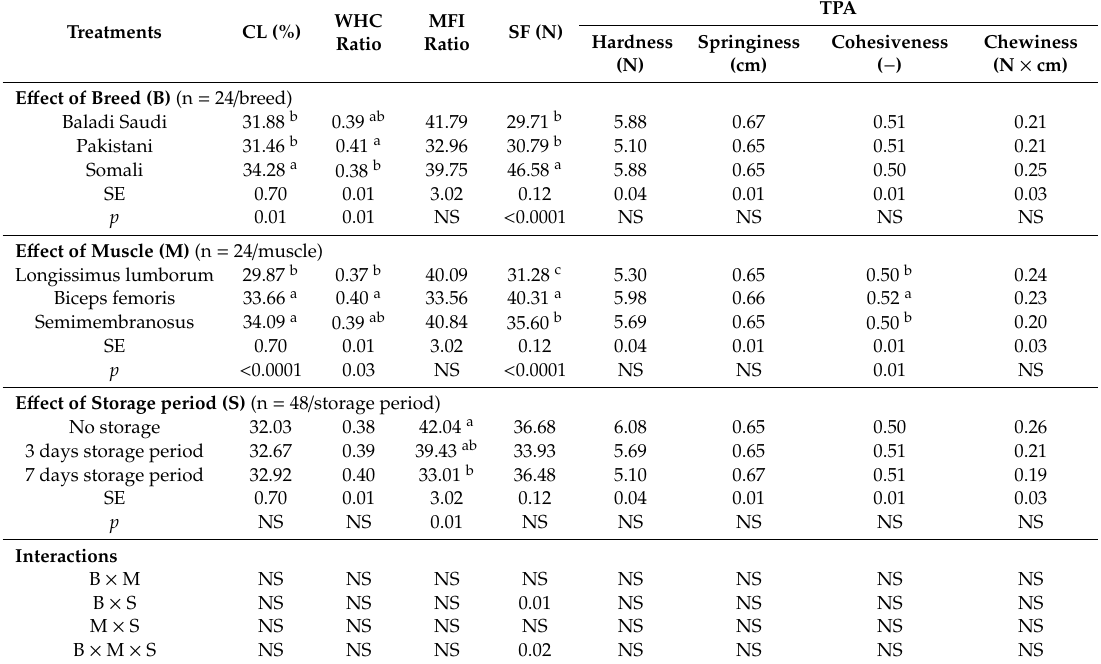
Table 3. E ff ect of breed, muscle type, and storage period on cooking loss (CL), water-holding capacity (WHC), myofibril fragmentation index (MFI), shear force (SF), and texture profile analysis (TPA) of camel meat.